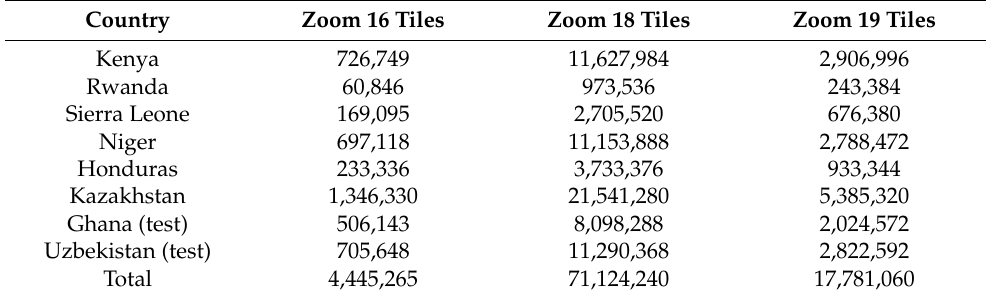
Table 3. Populated tiles in zoom 16 were generated using OSM data and